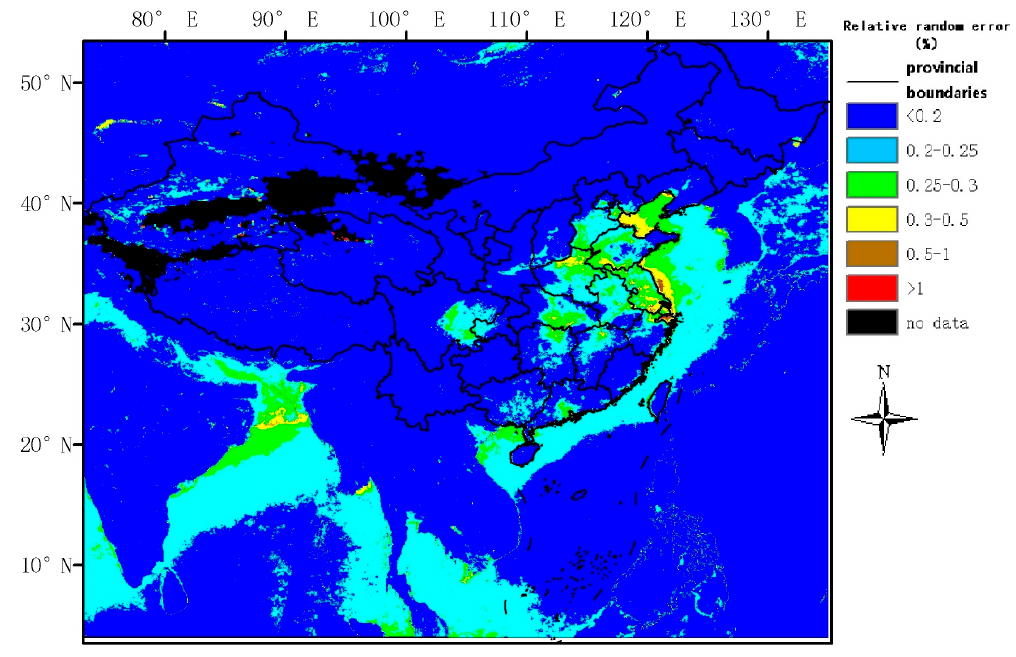
Figure 12. Performance evaluation results. All parameters used to produce this figure are the same as those used in Figure 11 except the orbit height. The orbit height for Figure 11 is 705 km, while for this figure it is 450 km.